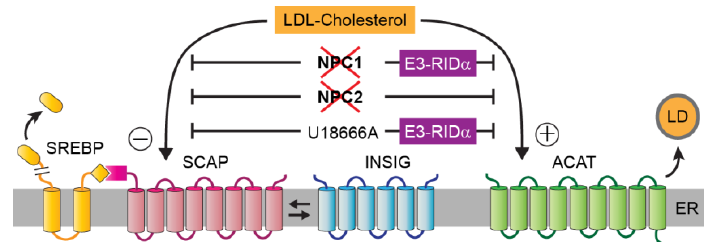
Figure 2. Endoplasmic reticulum (ER) cholesterol homeostatic machinery. Membrane-bound sterol regulatory element-binding protein (SREBP) precursors are retained in the ER through a tight association with the SREBP escort protein SCAP and the ER-resident protein INSIG. When ER cholesterol levels fall below a critical threshold level, SCAP dissociates from INSIG and mediates the COPII-dependent transport of SREBP precursor to the Golgi. Mature SREBP transcription factors are released by Golgi-resident proteases, and subsequently translocate to the nucleus where they activate genes involved in cholesterol uptake and de novo cholesterol synthesis. Excess-free cholesterol is stored in lipid droplets (LD) as acyl-CoA:cholesterol acyltransferase (ACAT)-generated cholesteryl esters. Negative SREBP feedback control and ACAT activity are both impaired in cells with reduced NPC1 and NPC2 function as well as following treatment with U18666A, a drug that phenocopies NPC by a direct interaction with the sterol-binding domain in NPC1. Ectopic RIDα expression is sufficient to restore ACAT activity, but not sterol regulation of SREBP, associated with reduced NPC1 function and U18666A treatment.